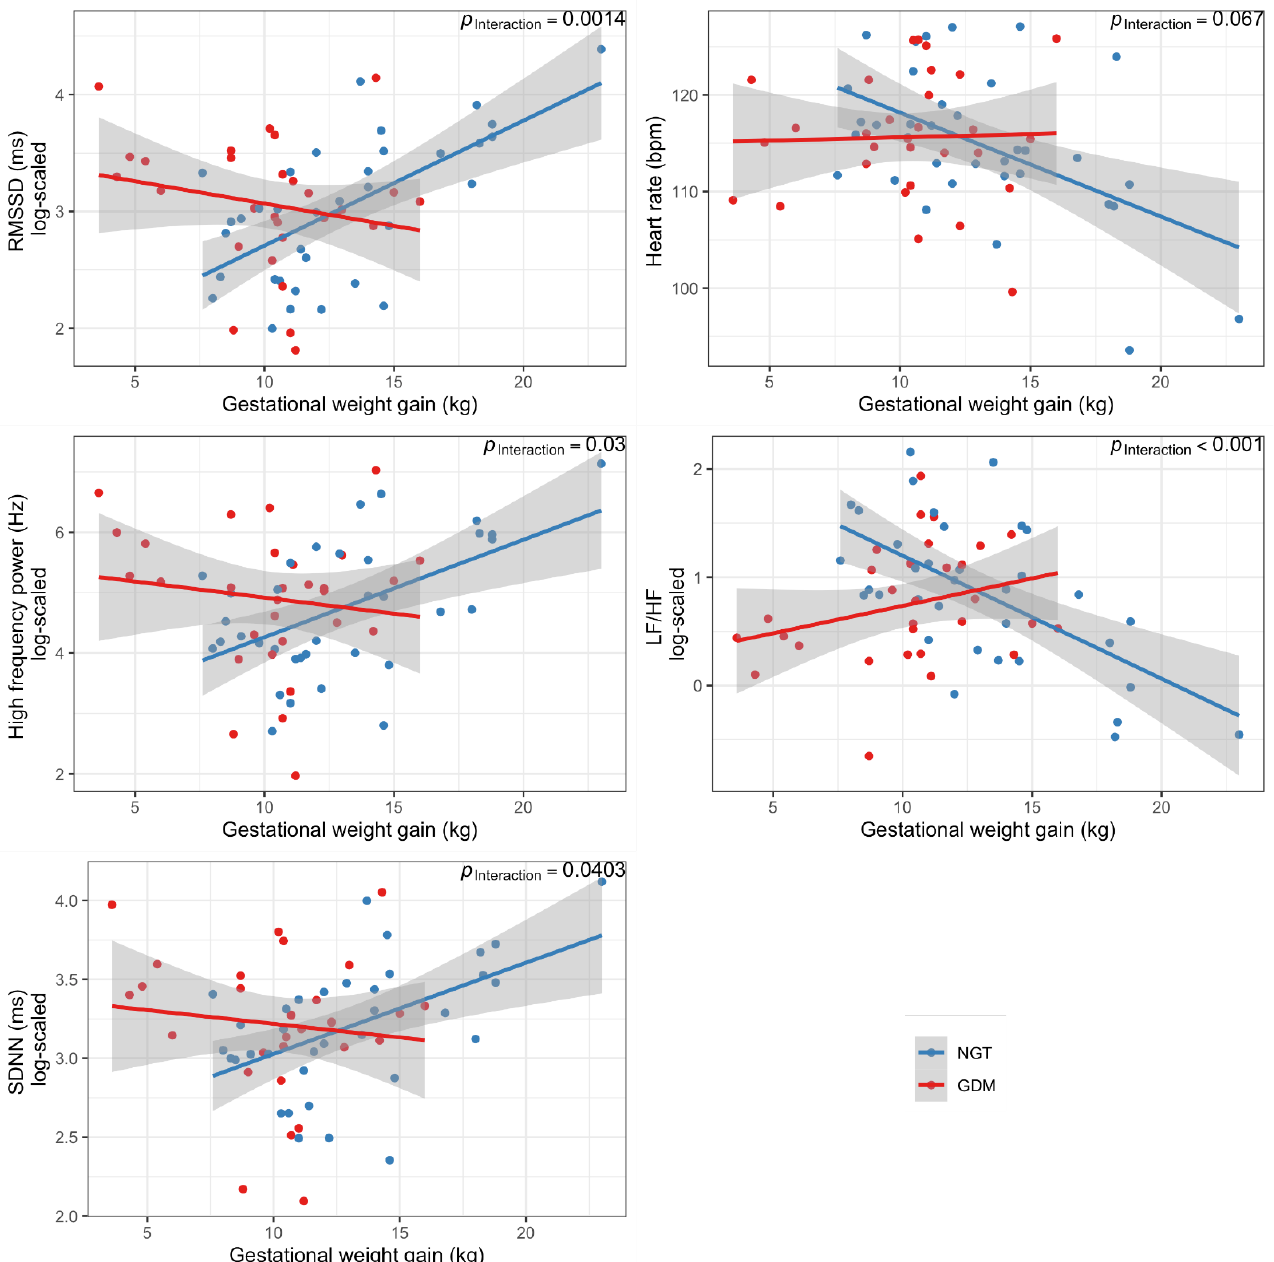
Figure 1. Association of total gestational weight gain with heart rate variability parameters of 2-year-old offspring in the whole cohort (by GDM status of the mother). RMSSD, root mean square of successive differences; SDNN, standard deviation of RR-Intervals; LF, low frequency; HF, high frequency; BPM, beats per minute.